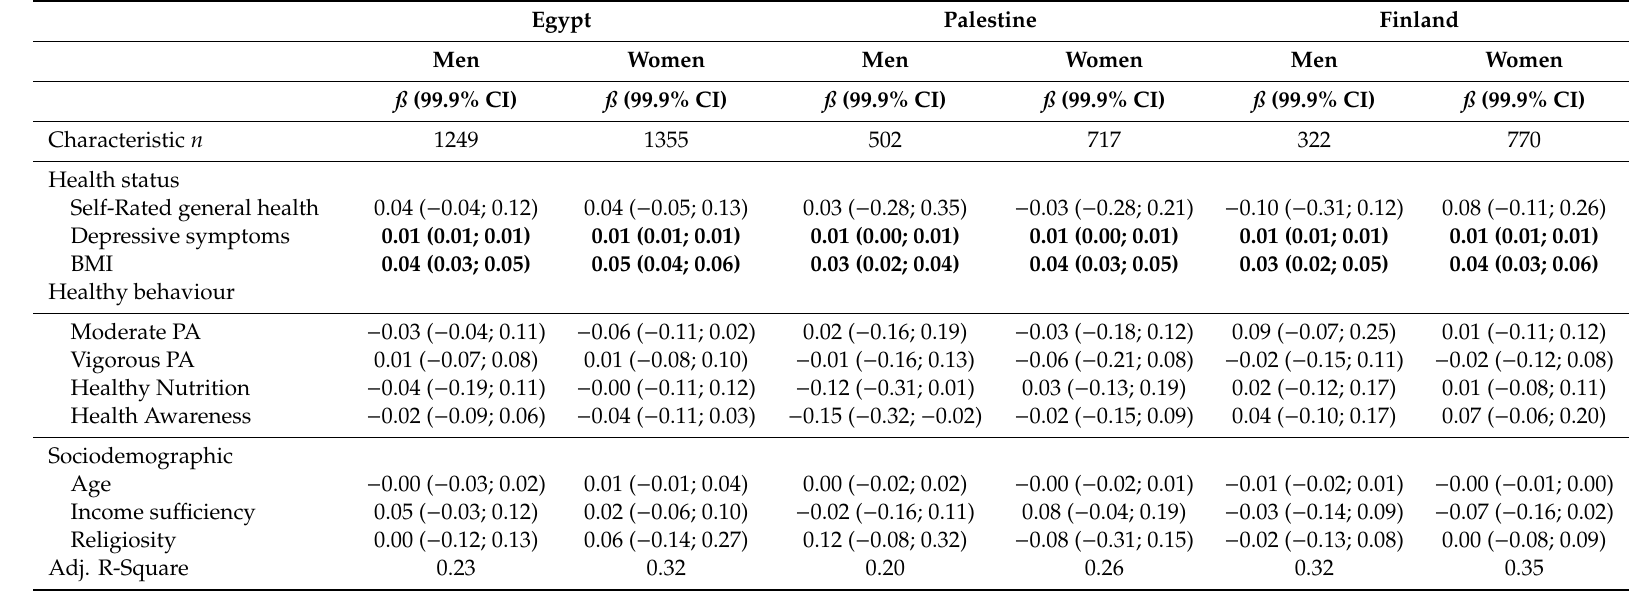
Table 4. Multivariable linear regression of health status, healthy behavior, and sociodemographic characteristics on body image concern * , stratified by country and sex.